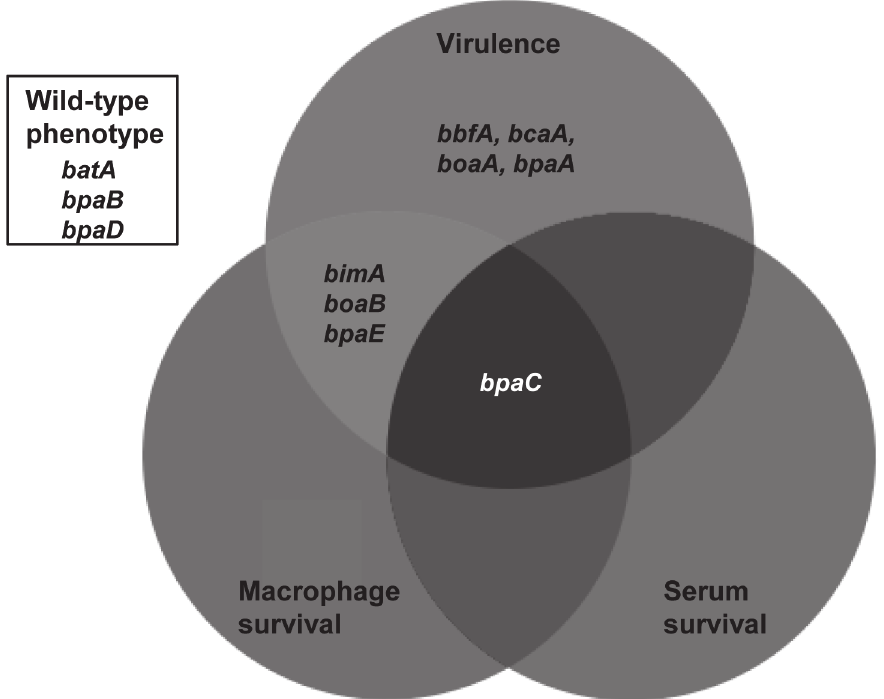
Fig 4. Systematic assessment of ATs for three pathogenesis-associated phenotypes. A Venn diagram of the phenotypic results of the complete repertoire of ATs for virulence in the BALB/c intra-peritoneal mouse melioidosis model, net intracellular replication in J774.2 macrophage-like cells and survival in 45% (v/v) normal human